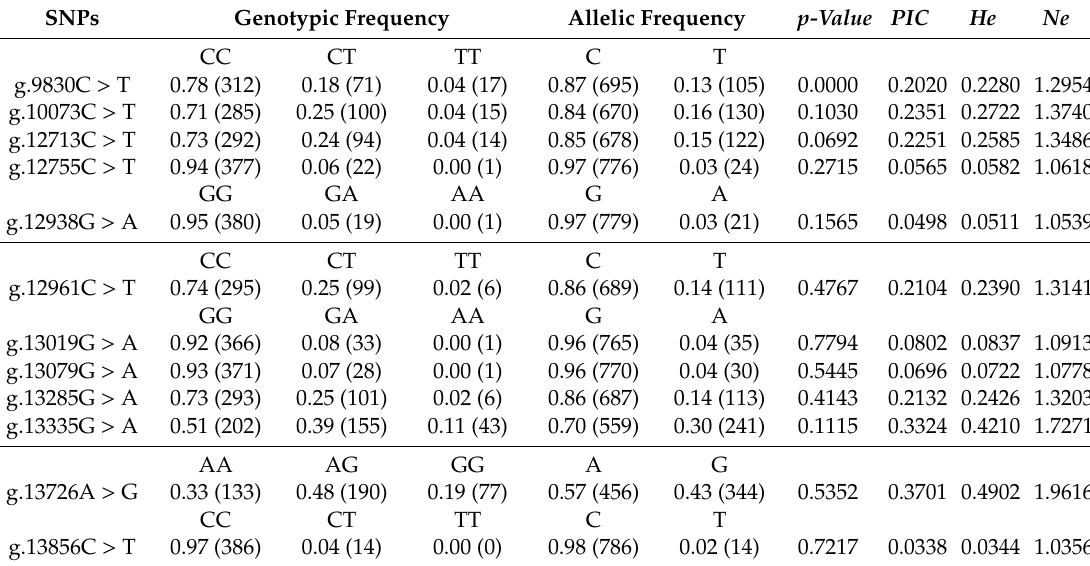
Table 3. Genotypic frequency, allelic frequency and diversity parameter in the exons of the PITX2 gene in Wuliang Mountain Black-bone